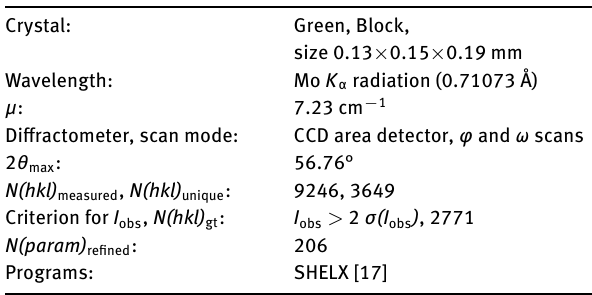
Table 1: Data collection and handling.